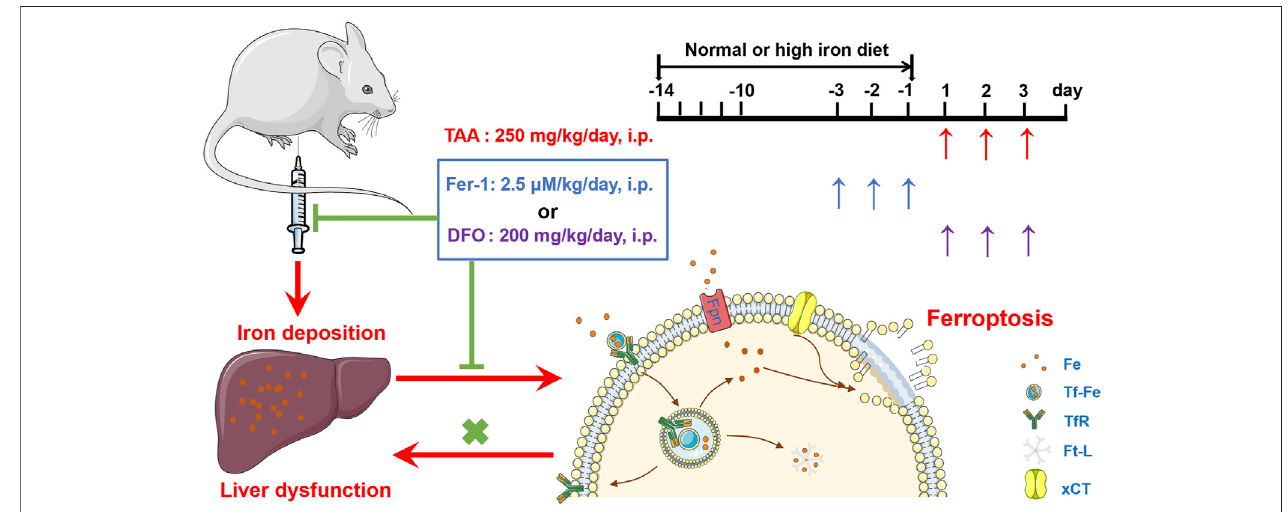
FIGURE 7 | Proposed mechanisms of the ferroptosis inhibitor Fer-1 against the TAA-induced ALI mice model.